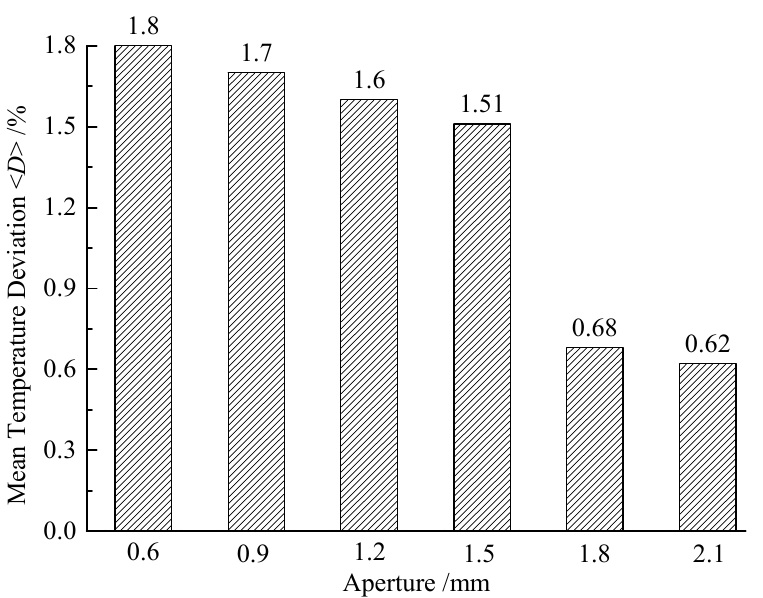
Figure 12. The effect of fracture aperture on mean deviation < D > from NPCTF for JRC = 16.34 fracture.